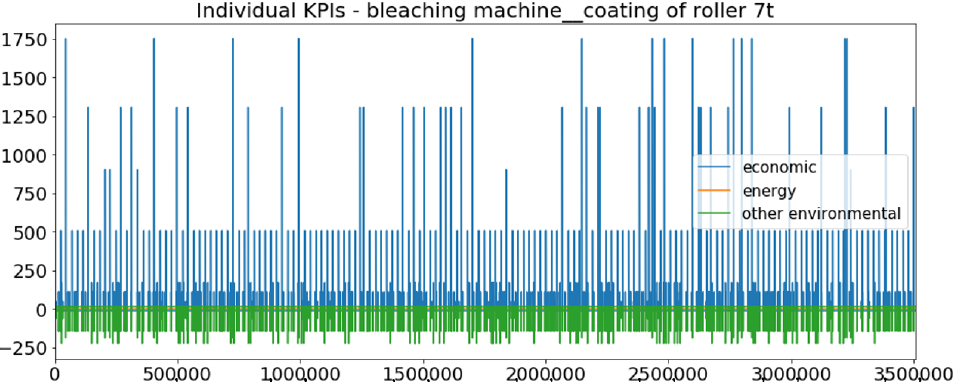
Figure 15. Individual KPI time series for the coating of the top roller yielded from running the model with paired coated rollers for the bleaching machine (ZORLUTEKS). The simulation interval has the same length as for training (200